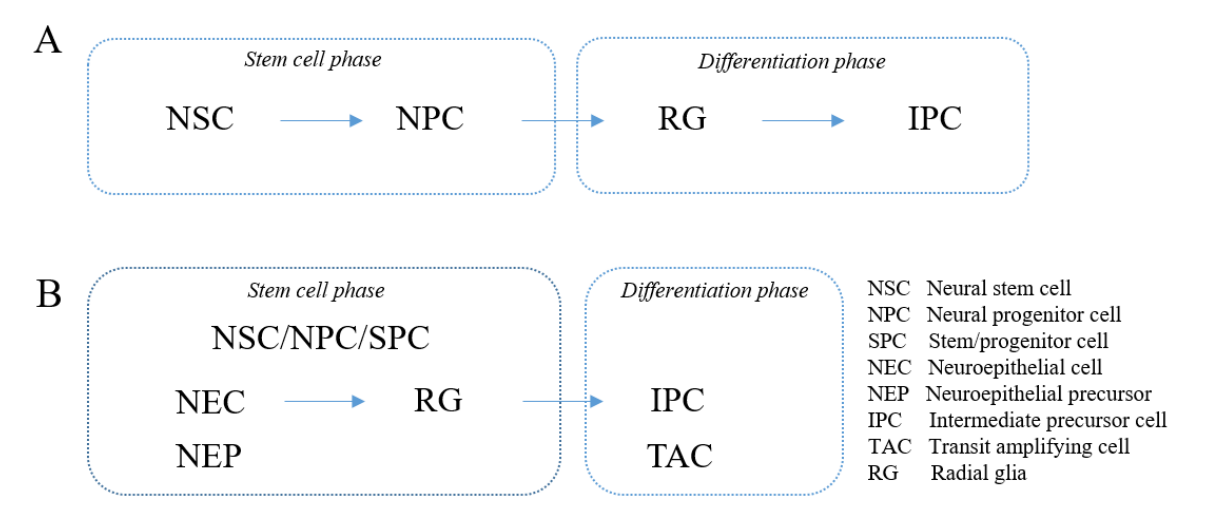
Figure 1. Terminology used to describe cells that appear during CNS development. (A) Recently proposed method in which a periodic table of cell types is proposed with stem cell and differentiation phase (29). (B) Additional terms collected from the literature. NSC, Neural stem cell; NPC, Neural progenitor cell; SPC, stem/progenitor cell; NEC, Neuroepithelial cell; NEP, Neuroepithelial precursor; RG, Radial glia; IPC, Intermediate precursor cell; TAC, Transit amplifying